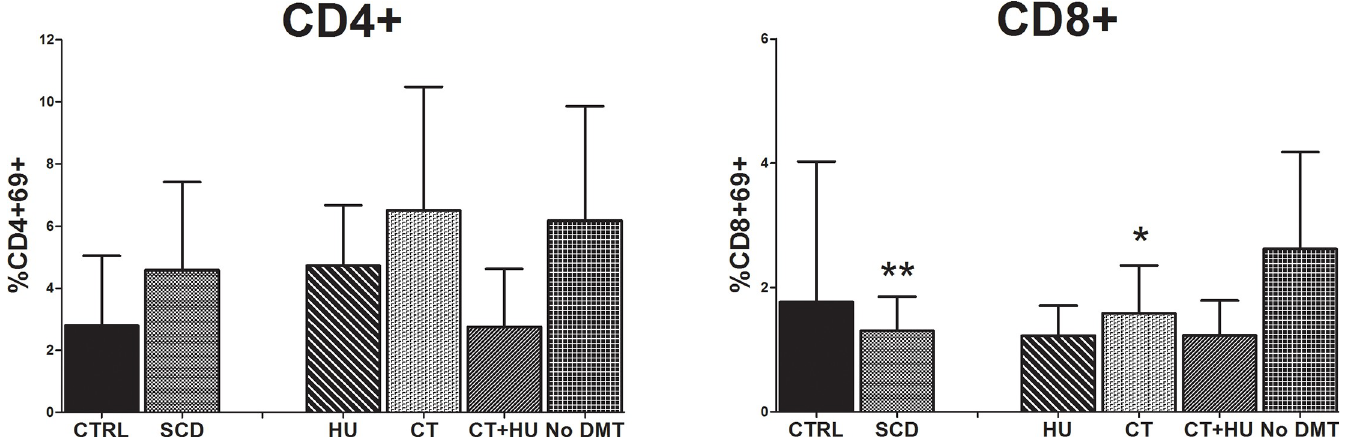
Fig 3. Lymphocyte transformation test (LTT) after activation with influenza vaccine. Results are expressed as the ratio of (A) (%CD4 + CD69 + after influenza vaccine stimulation) / (%CD4 + CD69 + in basal conditions) and (B) (%CD8 + CD69 + after influenza vaccine stimulation) / (%CD8 + CD69 + in basal conditions). Median ratio with IQR are represented for each group. HU, Hydroxyurea; CT, Chronic transfusion; No DMT, No Disease modifying therapy. � p < 0.05; �� p < 0.01; ��� p < 0.005.